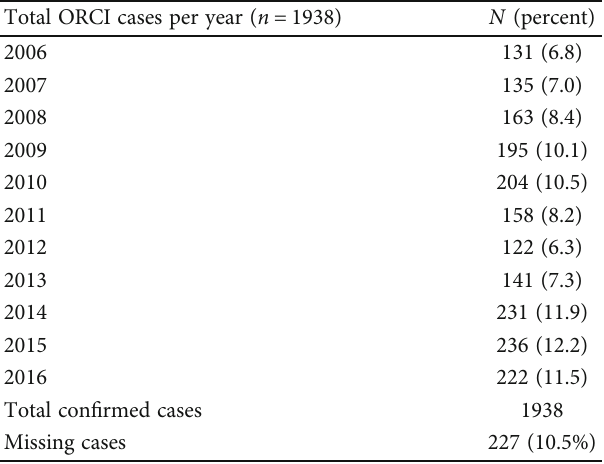
Table 1: Distribution and number of esophageal cancer cases from Ocean Road Cancer Institute (ORCI) from the year 2006-2016.